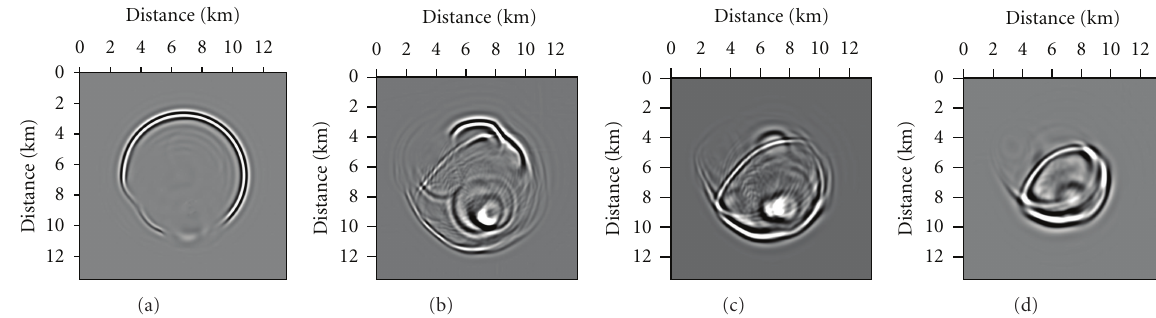
Figure 10: Impulse response of FFDPI migration with two-way splitting using 10 reference velocities. Horizontal cuts as in Figure